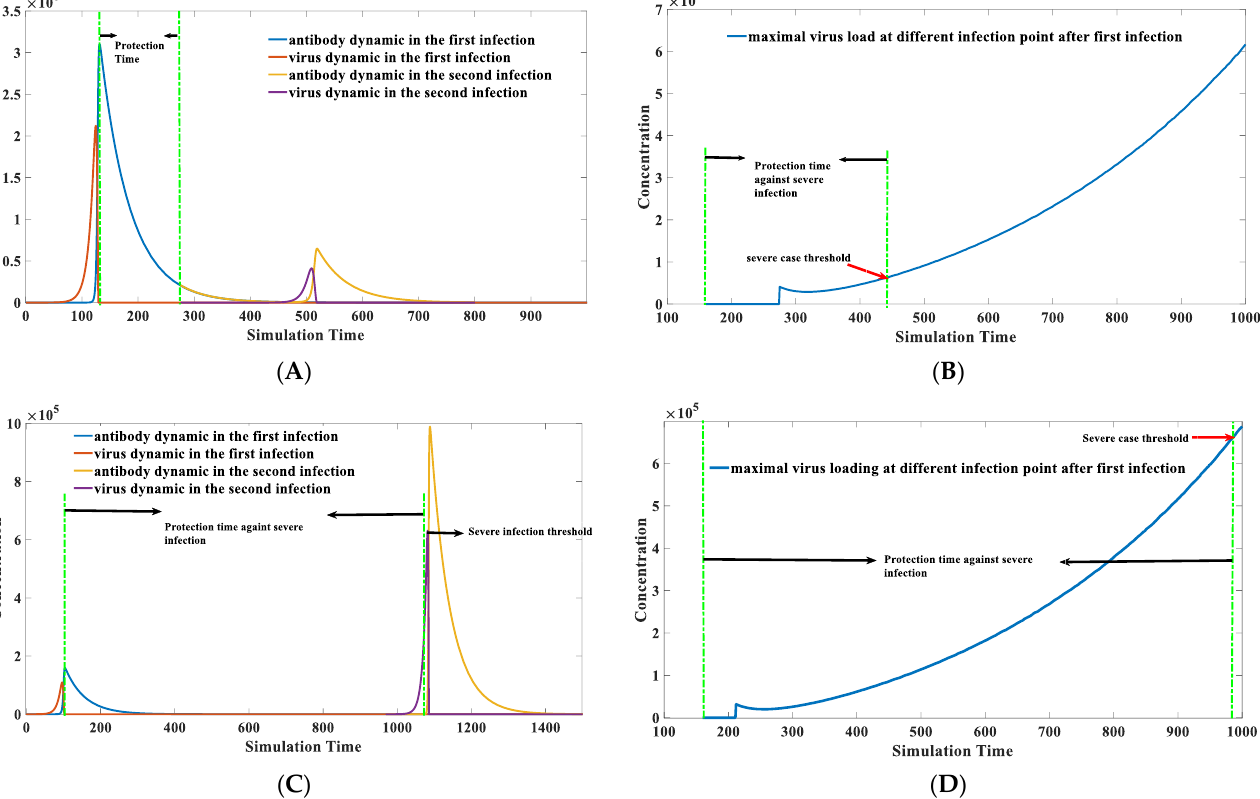
Figure 9. Protection time calculation when the antibody has a specific binding kinetic constant k 2 . It can be inferred from this figure that a fast-binding neutralizing antibody would provide a longer protection time when we compared ( A ) with ( C ). The protection time against severe infection can also be prolonged, given the faster binding kinetics when comparing ( B ) to ( D ). ( A ) Protection time calculation when the antibody has a weak binding kinetic constant k 2 = 1 × 10 − 6 . The parameter set we used is: x (0) = 0, y (0) = 100, z (0) = 10, q (0) = 1 × 10 6 , k 1 = 0.1, k 2 = 1 × 10 − 6 , k − 2 = 1 × 10 − 14 , k 3 = 1, k 4 = 2, k 5 = 0.02, k 6 = 0.02, k 7 = 1 × 10 − 9 , k − 7 = 1 × 10 − 14 . ( B ) Maximal virus load at different infection points when the antibody has a binding kinetic constant k 1 = 1 × 10 − 6 . The parameter set used is the same as ( A ). ( C ) Protection time calculation when the antibody has a strong binding kinetic constant k 2 = 1 × 10 − 5 . The parameter set we used is: x (0) = 0, y (0) = 100, z (0) = 10, q (0) = 1 × 10 6 , k 1 = 0.1, k 2 = 1 × 10 − 5 , k − 2 = 1 × 10 − 14 , k 3 = 1, k 4 = 2, k 5 = 0.02, k 6 = 0.02, k 7 = 1 × 10 − 9 , k − 7 = 1 × 10 − 14 . ( D ) Maximal virus load at different infection points when the antibody has a binding kinetic constant k 2 = 1 × 10 − 5 . The parameter set used is the same as ( C